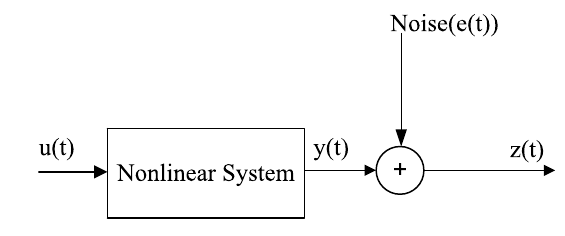
Figure 1: Open Loop nonlinear system with additive